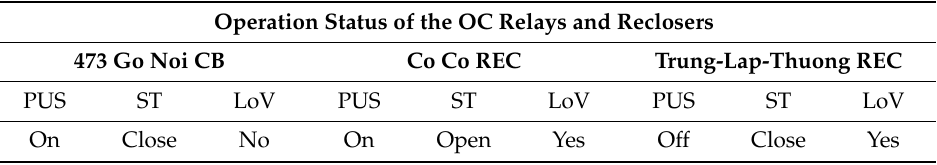
Figure 9. DPGF waveforms at the 473 Go-Noi feeder: ( a ) three phase currents Ia (A), Ib (A), Ic (A) and ground current Ig (A); ( b ) three phase voltages (Va (V),Vb (V), and Vc (V)); ( c ) tripping signals of the Co-Co recloser (51P1, 51P2, 50P2 are phase tripping signals; 50G2, 51G1, 51G2 are ground tripping signals; 52A shows a closed status of the recloser; and a TRIP signal shows the tripping action performed by the recloser). Table 16. The operation status of the OC relays and reclosers with respect to the fault